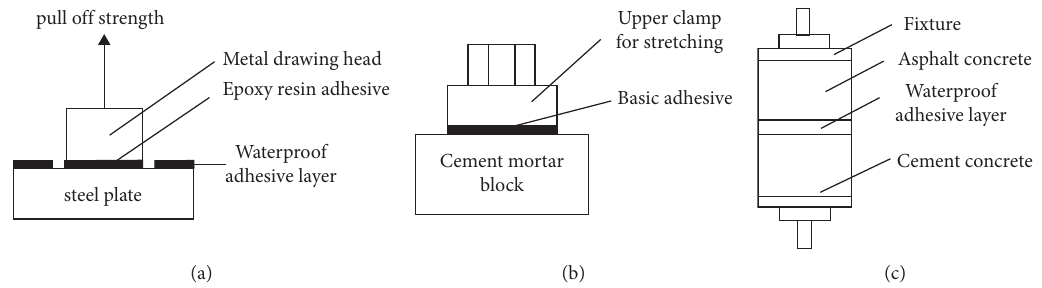
Figure 7: Test method of bonding strength between waterproof adhesive layer and steel